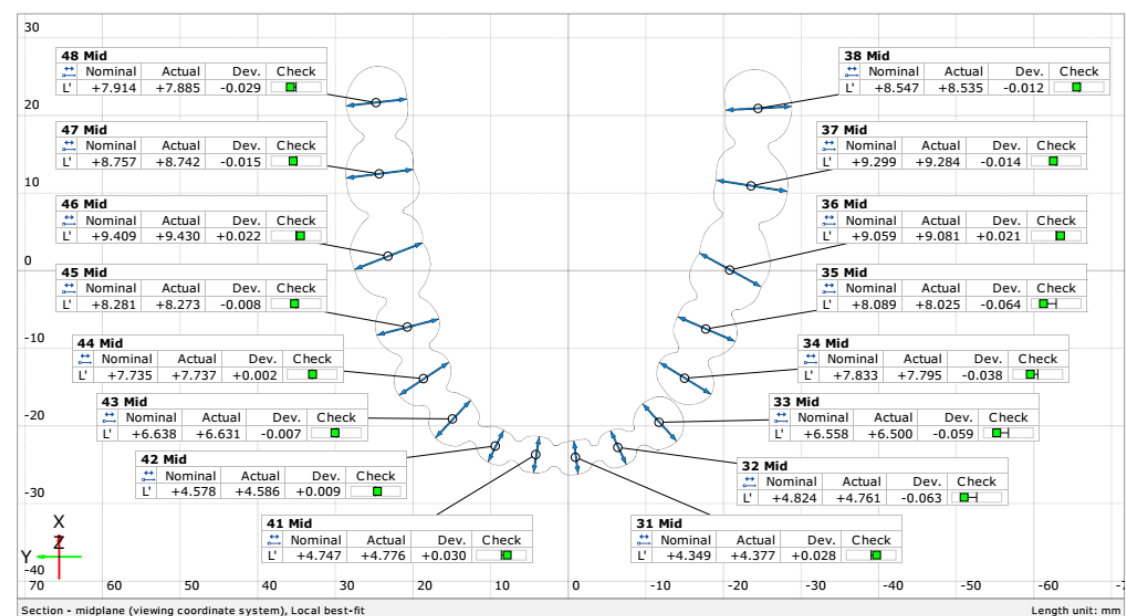
Figure 6. Section measurements in the buccolingual direction for each tooth.